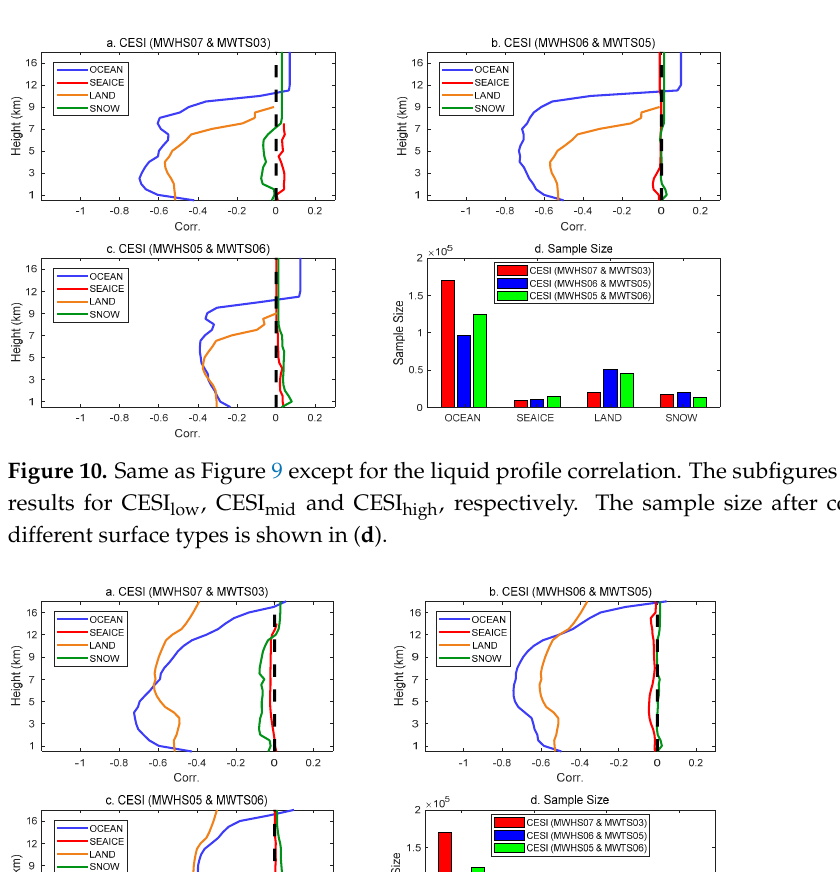
Figure 9. Vertical distributions of the correlation coefficient between CESIs derived from ( a ) CESI low , ( b ) CESI mid and ( c ) CESI high , and GPROF solid profiles. The blue, red, brown and green curves in figures ( a – c ) represent results over ocean, sea ice, land and snow conditions, respectively. The dashed black lines represent the zero value. The sample size after collocation over different surface types is shown in ( d ). The testing dataset is February, May, August and November in 2018.